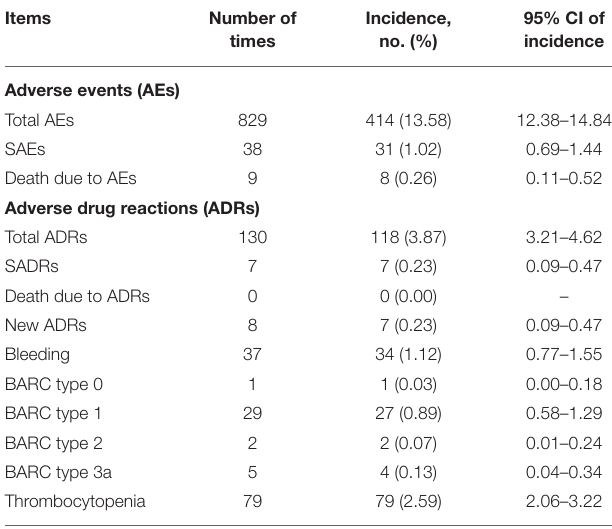
TABLE 1 | Clinical characteristics of participants. TABLE 2 | Summary of AEs and